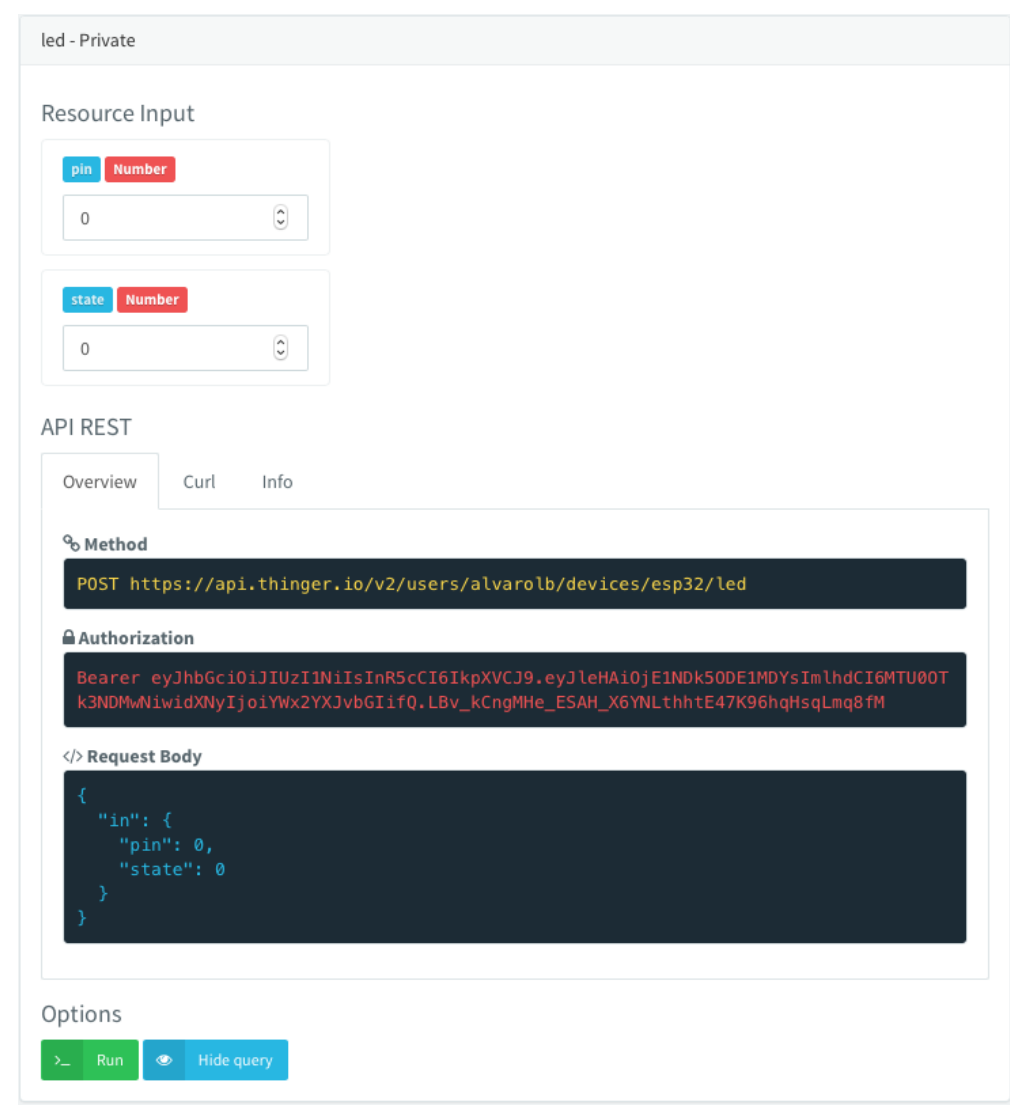
Figure 6. Example of how a resource definition modelled in the device, like turning on/off a digital pin, is automatically converted to an REST API endpoint that can be executed directly from the console or any other third party